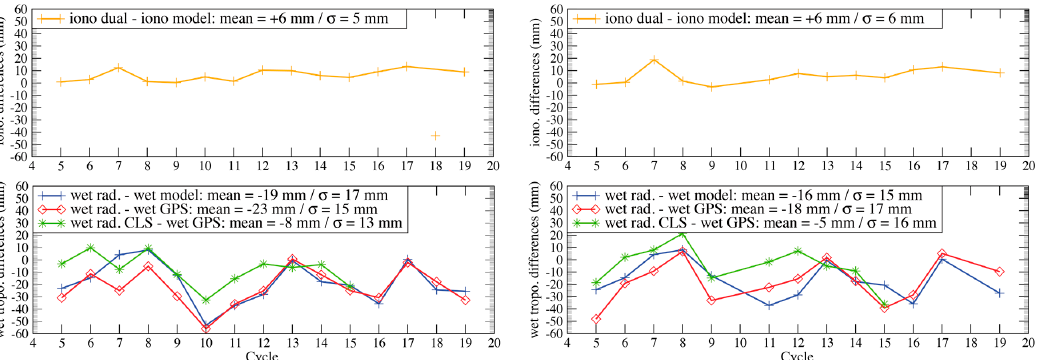
Figure 2. Sentinel-3A corrections differences at the Senetosa ( left ) and Ajaccio ( right ) calibration sites. Ionospheric correction differences in the upper panels. Wet tropospheric correction differences in the lower panels.